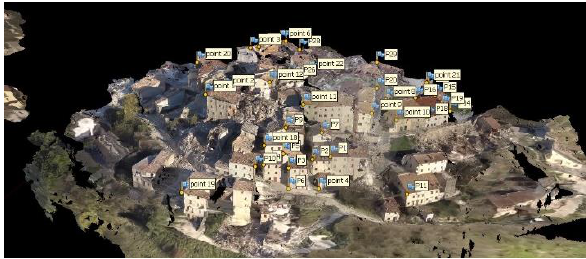
Table 1. Prior information: data on the technical map (CTR) of Castelluccio provided by Region Umbria